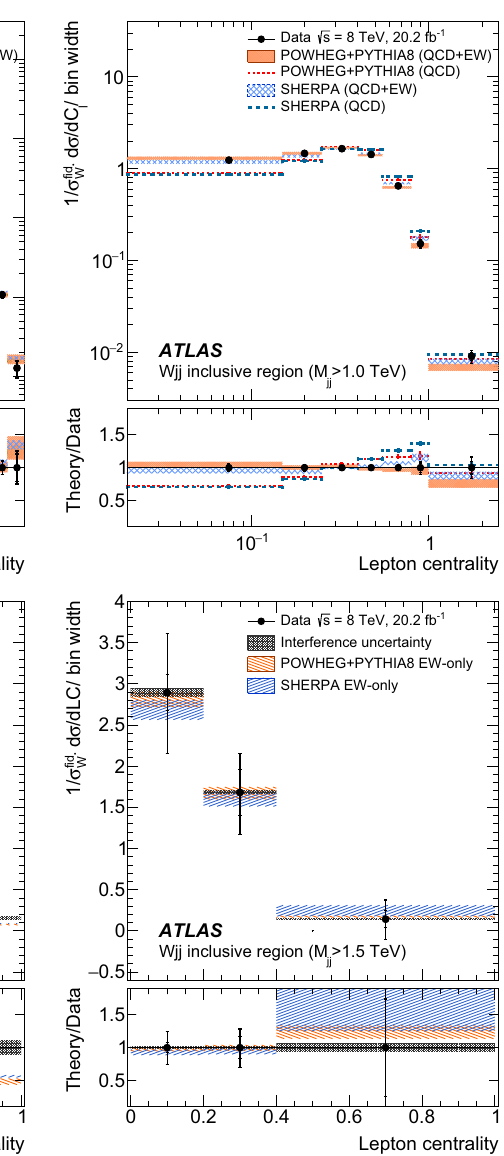
statistical ( inner bar ) and total ( outer bar ) measurement uncertainties are shown, as well as ratios of the theoretical predictions to the data (the bottom panel in each